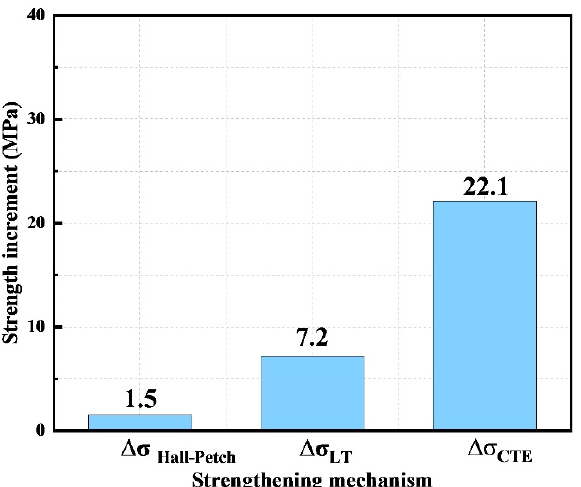
Figure 9. Calculated strength increment contributed by different strengthening mechanisms.